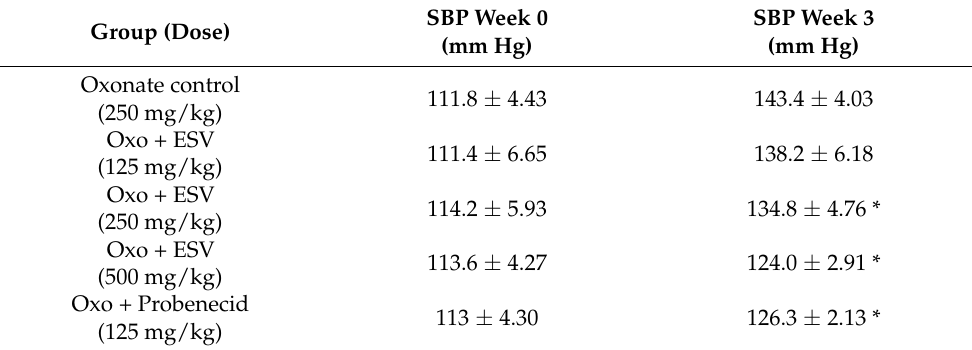
Table 3. The antihypertensive effect of the extract from S. virgaurea (ESV) in hyperuricemic rats. Group